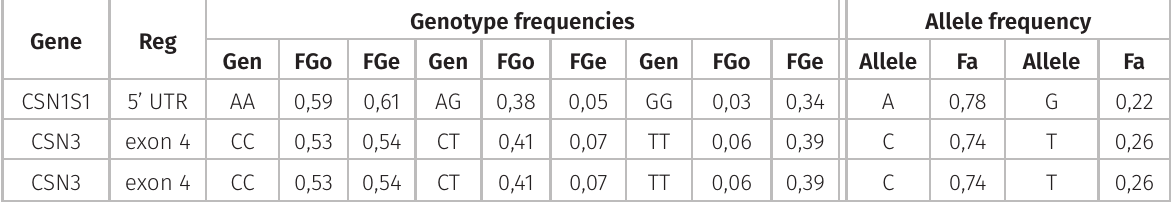
Table II. The observed, expected, and allelic genotypic frequencies of the casein CSN1S1 and CSN3 genes . ‘ N’, ‘Reg’, and ‘Gen’ refer to the nucleotide number, gene region, and genotype, respectively. ‘F’ indicates frequency, where ‘FGo’, ‘FGe’, and ‘Fa’ refer to the observed, expected, and allelic genotypic frequencies, respectively. Genotype frequencies Allele Gene Reg